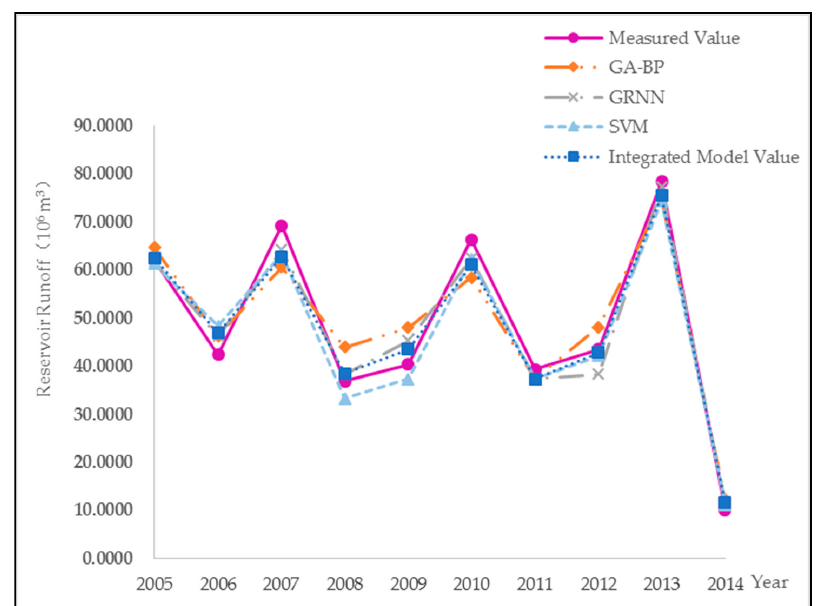
Figure 4. Simulated training results for the Wohushan Reservoir.